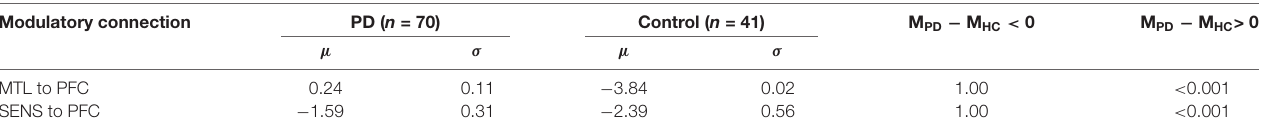
TABLE 1 | Group comparison of modulatory connectivity between PD and Control